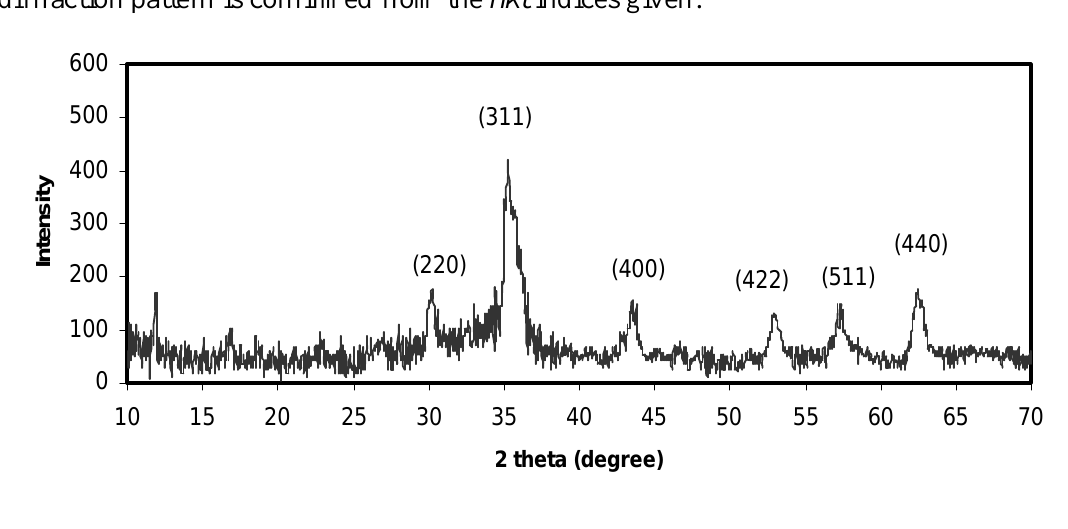
O nanoparticles. The spinel 3 4